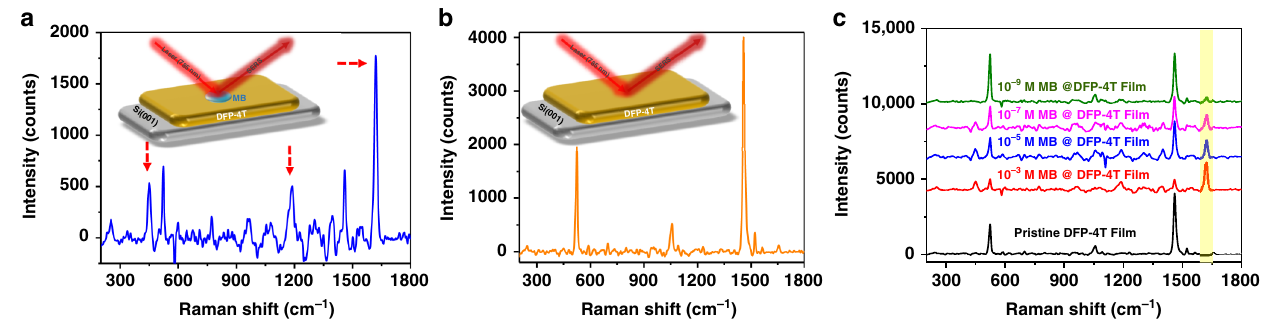
Fig. 2 Raman enhancement for nanostructured DFP-4T fi lms. a The SERS spectrum of MB probe (10 − 3 M) on nanostructured DFP - 4T fi lm (characteristic Raman peaks are indicated). b Raman spectrum of pristine nanostructured DFP - 4T fi lm. c SERS spectra of MB on nanostructured DFP - 4T fi lm at different